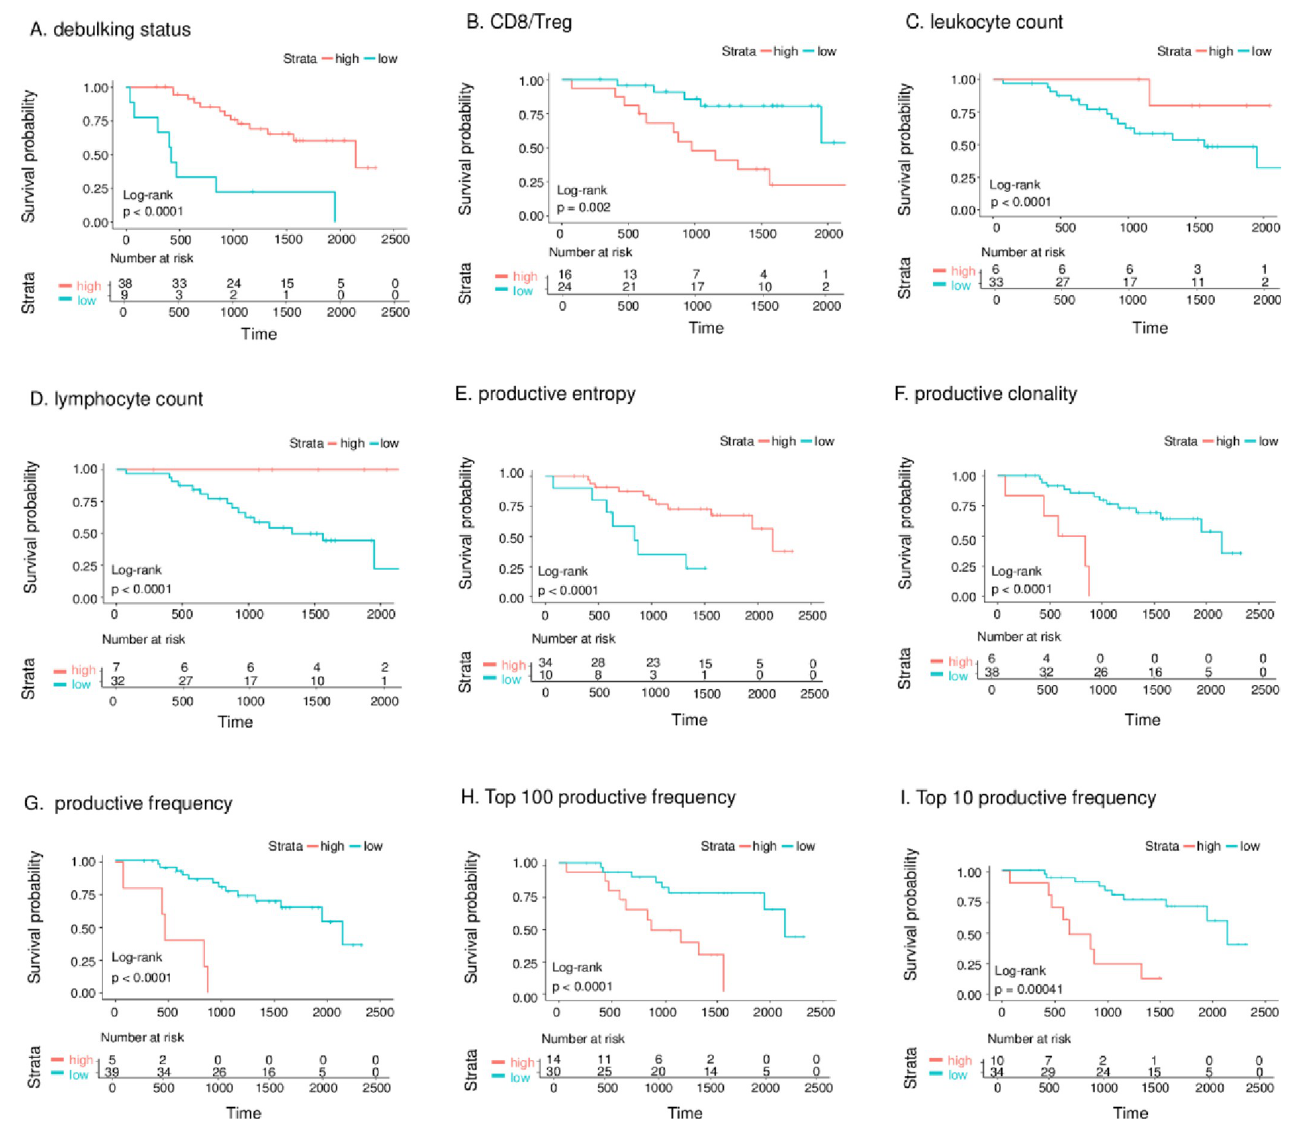
Fig 2. Kaplan–Meier curves of overall survival for various factors. (A) Debulking status. (B) CD8/Treg ratio. (C) Total leukocyte counts. (D) Total lymphocyte count. (E) Productive entropy. (F) Productive clonality. (G) Maximum productive frequency. (H) Top 10 productive frequency. (I) Top 100 productive